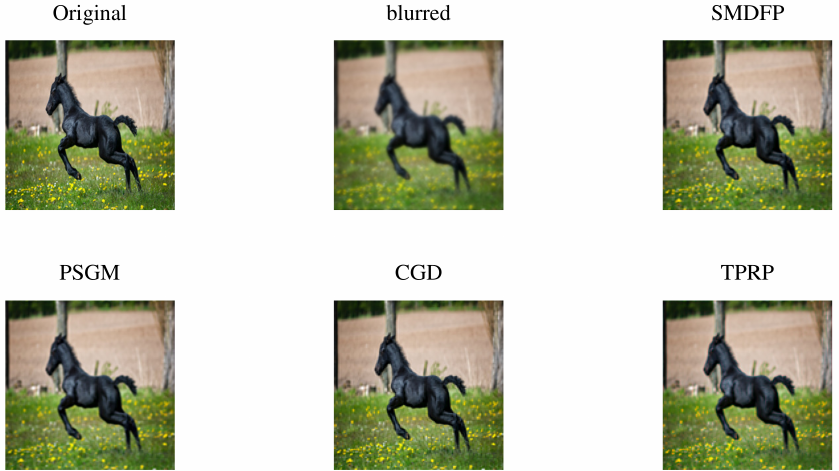
Figure 7. Comparison of the original image, blurred image, SMDFP image, CGD image, PSGM image, and TPRP image for the number of iterations, CPU time, MSE, and